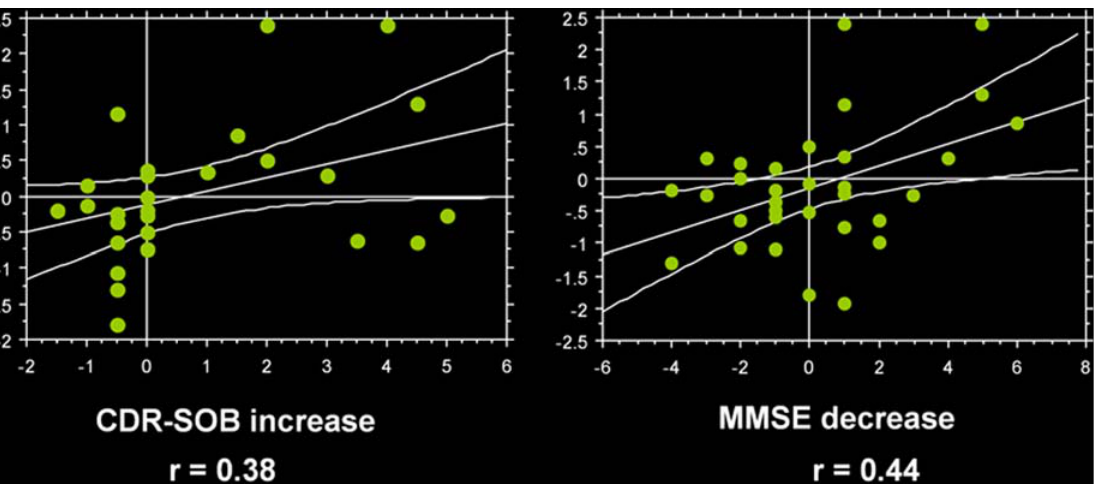
Figure 4. Scatterplots demonstrate activation magnitude parameter estimate in the PMC region (on the y-axis) significantly (p , 0.05) correlated with longitudinal change in cognitive measures (increase in CDR-SOB, decrease in MMSE) in the MCI